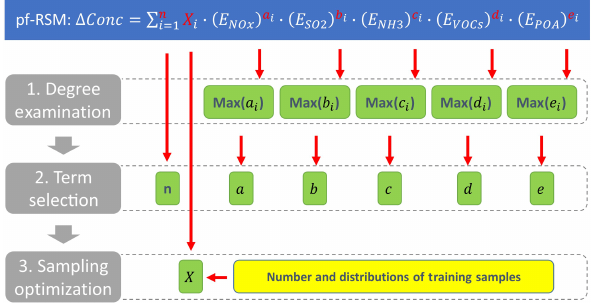
Figure 2. Flow scheme of pf-RSM